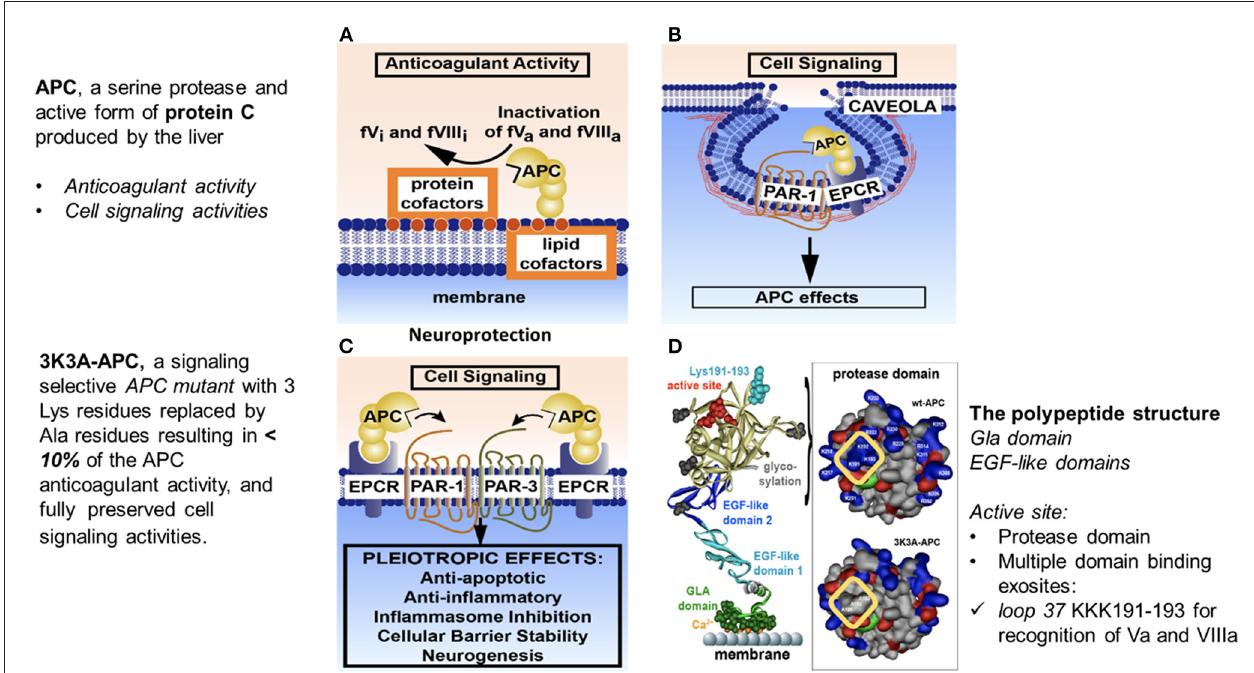
FIGURE 1 | Anticoagulant and cell-signaling pathways of APC and the structure of signaling-selective 3K3A-APC. APC, activated protein C; BBB, blood–brain barrier; EGF, endothelial growth factor; EPCR, endothelial protein C receptor; GLA, gamma-carboxyglutamic acid; PAR, protease-activated receptor. Reprinted from blood, vol. 132(2), Griffin et al. (67) activated protein C, protease activated receptor 1 and neuroprotection; 159–169, 2018, with permission from the American Society of Hematology. (A) Anticoagulant activity of APC involves the proteolytic inactivation of factors Va and VIIIa on membrane surfaces containing phospholipids that are derived from cells, platelets, lipoproteins, or cellular microparticles. The irreversible inactivation of factors Va and VIIIa to yield inactive factors Vi and VIIIi by APC is accelerated by a variety of lipid and protein cofactors (e.g., glucosyl ceramide, protein S, etc). (B) Beneficial direct effects of APC on cells require the EPCR and PAR-1. One distinction between pro-inflammatory thrombin signaling and cytoprotective APC signaling is the localization of APC signaling in the caveolin-1–rich microdomains (caveolae). (C) Neuroprotective mechanisms for APC effects on cells may also involve other receptors including PAR-3. APC-initiated signaling effects on cells can include anti-apoptotic activities, anti-inflammatory activities, inhibition of the inflammasome, stabilization of endothelial barrier functions, including the BBB, and neurogenesis. (D) The polypeptide structure of APC comprises an N-terminal GLA domain (green) that binds to negatively charged lipids and EPCR, 2 EGF-like domains (light blue and dark blue), and the protease domain containing the active site triad of serine, histidine, and aspartic acid residues (red). Four glycosylation sites are indicated by gray-shaded moieties. Substrate selectivity of this protease is determined by interactions between the targeted substrates and the active site and also by multiple unique binding exosites on APC that vary for different substrates. The protease domain space–filled model (see insert in D) highlights in the yellow box 3 positively charged lysine (K) residues within the so-called 37 loop (KKK 191–193), which is an exosite for APC’s recognition of factors Va and VIIIa. Mutation of these 3 lysine residues to alanine (3K3A-APC) reduces APC’s anticoagulant activity by > 90% but does not affect its interactions with the cytoprotective substrates, PAR-1, PAR-3, or its other known cell-signaling receptors. Thus, 3K3A-APC is very “signaling-selective”.